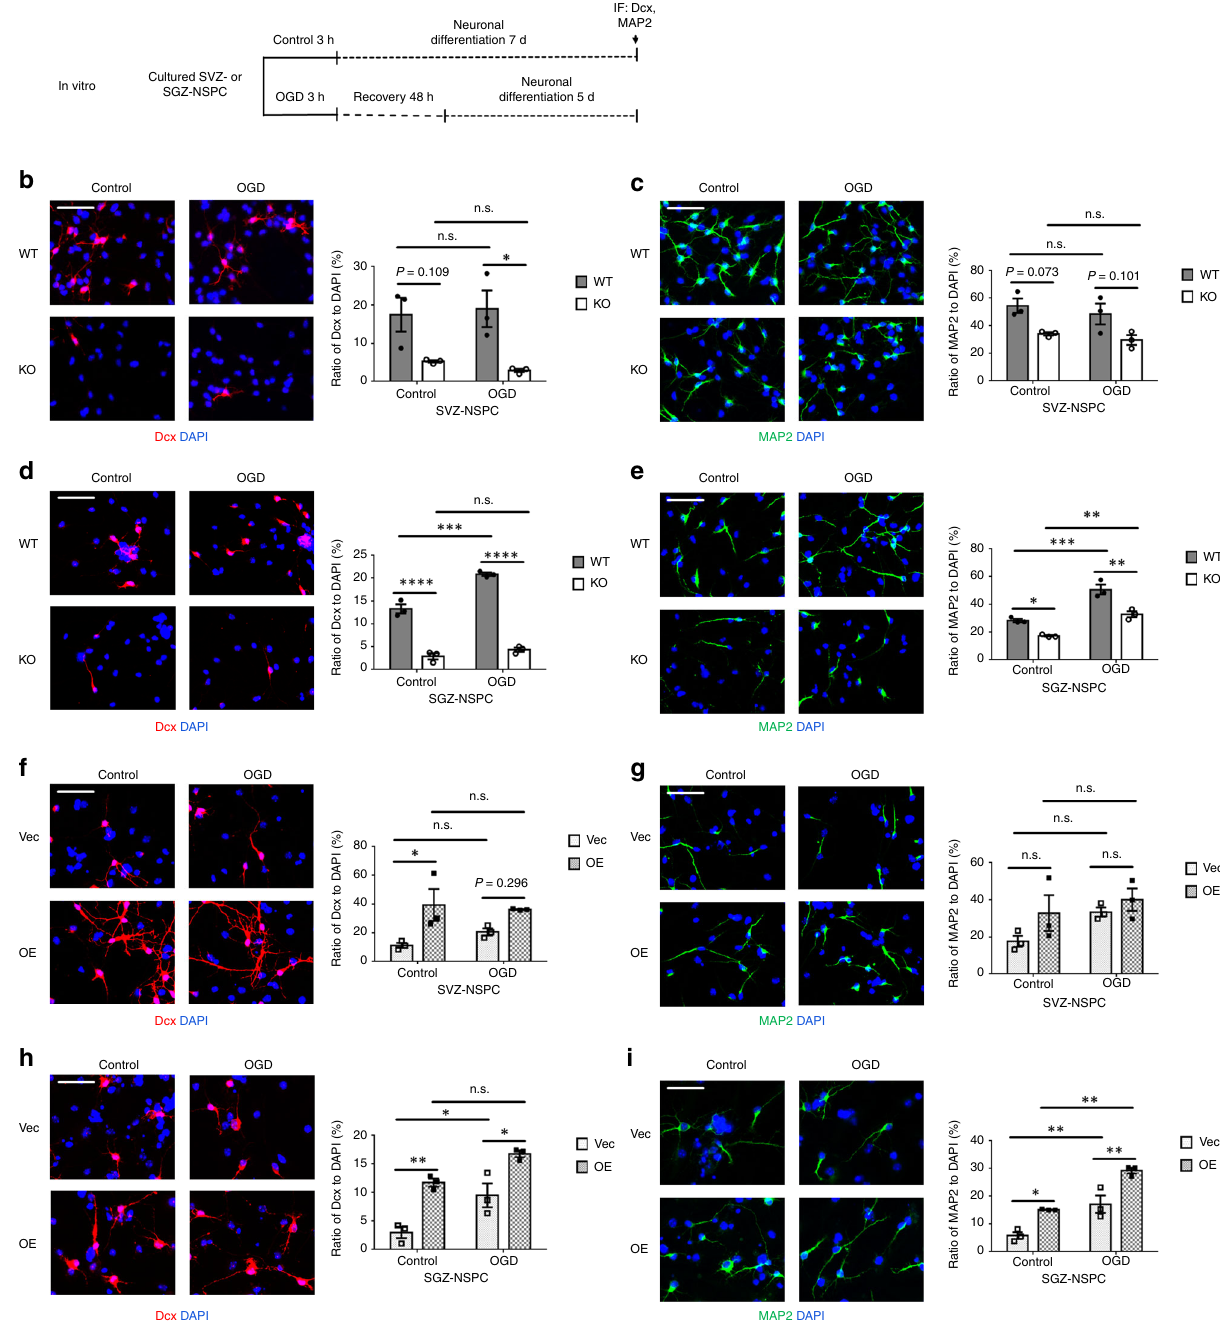
Fig. 3 RBM3 promotes neuronal differentiation of both SVZ-NSPC and SGZ-NSPC after OGD in vitro. a Illustration of in vitro neuronal differentiation assay. NSPCs were cultured in neuronal differentiation medium for 7 days (control), or fi rst challenged with OGD and then reoxygenated in NSPC complete culture medium for the fi rst 2 days, followed by switching to neuronal differentiation medium for 5 days (OGD). OGD oxygen-glucose deprivation, IF immuno fl uorescence. b – i RBM3 WT and KO NSPCs from SVZ ( b , c ) or SGZ ( d , e ), and WT NSPCs transfected with empty vector (Vec) or RBM3 overexpressing vector (OE) with SVZ ( f , g ) or SGZ ( h , i ) origins were used in neuronal differentiation assay. Neuroblast marker Dcx ( b , d , f , h ) and neuronal marker MAP2 ( c , e , g , i ) were stained and the ratio of immunoreactive cells to DAPI-positive cells was calculated (three independent experiments, n = 3). Representative images were presented and statistical data were acquired. Scale bar: 50 µ m. Two-way ANOVA was used for statistical analysis; n.s. not signi fi cant; * p < 0.05; ** p < 0.01; *** p < 0.001; **** p < 0.0001. All data are presented as mean ± SEM cells, and was also present in undifferentiated NSPCs (Supple- Similarly, we differentiated NSPCs into astrocytes and oligo- mentary Fig. 5b) as reported in other publications 20,21 , thus not dendrocytes with or without OGD treatment (Supplementary Fig. 5a). We used S100 to label glial precursors. The commonly used used. We found no difference when RBM3 expression was altered astrocyte marker GFAP was expressed in all the differentiated in an astrocyte differentiation assay (Supplementary Fig. 5c-f). NATURE COMMUNICATIONS| (2019) 10:3983